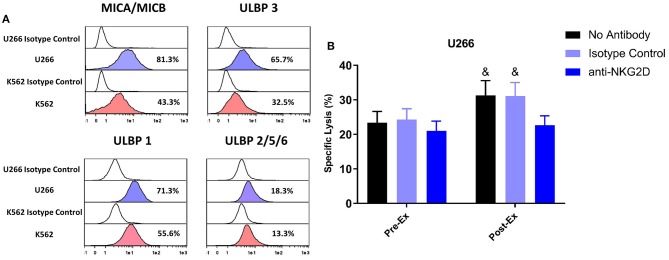
Enhanced cytotoxic effect of exercise expanded TCR-γδ T-cells against U266 cells is dependent on NKG2D signaling. (A) The expression of NKG2D ligands, MICA/MICB, ULBP 3, ULBP 1, and ULBP 2/5/6 on U266 and K562 target cell lines. (B) The percentage of U266 cells killed by Pre-Ex and Post-Ex expanded TCR-γδ T-cells under 3 different conditions: no antibody (media), isotype control (REA), and anti-NKG2D. Values are mean ± SE. Differences from Post-Ex anit-NKG2D condition are indicated by &, p < 0.05.